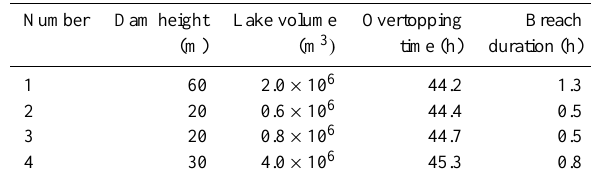
Table 4. Estimated failure time (by overtopping) of the downstream dams. The dam height and lake volume were reported by Xu et al. (2009), and are consistent with the calculation results by com- paring the pre- and post- earthquake